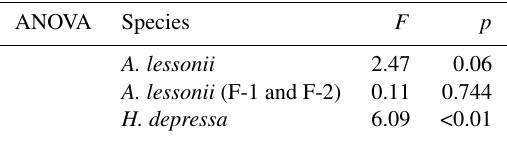
Table 4. ANOVA parameters of single-chamber